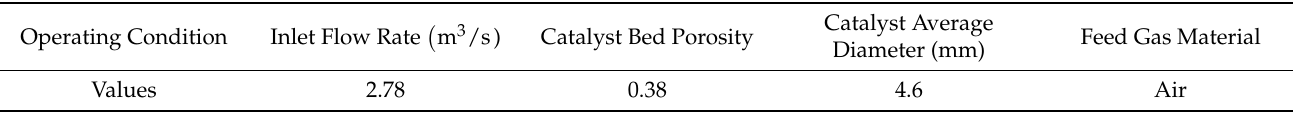
Table 2. Boundary conditions used in the